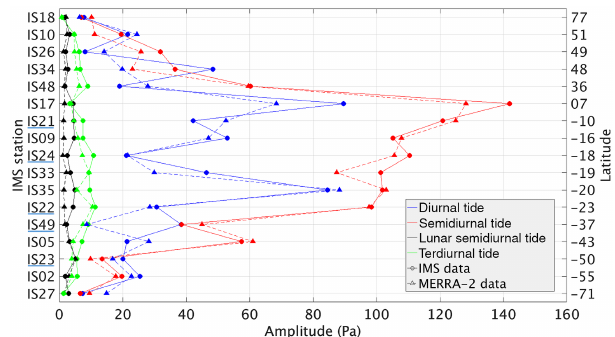
Figure 8. Comparison of the mean tidal amplitudes as calculated from the IMS sensors’ time series and MERRA-2 reanalysis. The mean amplitudes of the solar tides are in good agreement. The in- creased amplitude of the lunar tide at IS23 can be seen as misrep- resentation since it matches the MERRA-2 data in which the lunar tides are not represented (Fig. A2) as in Fig.